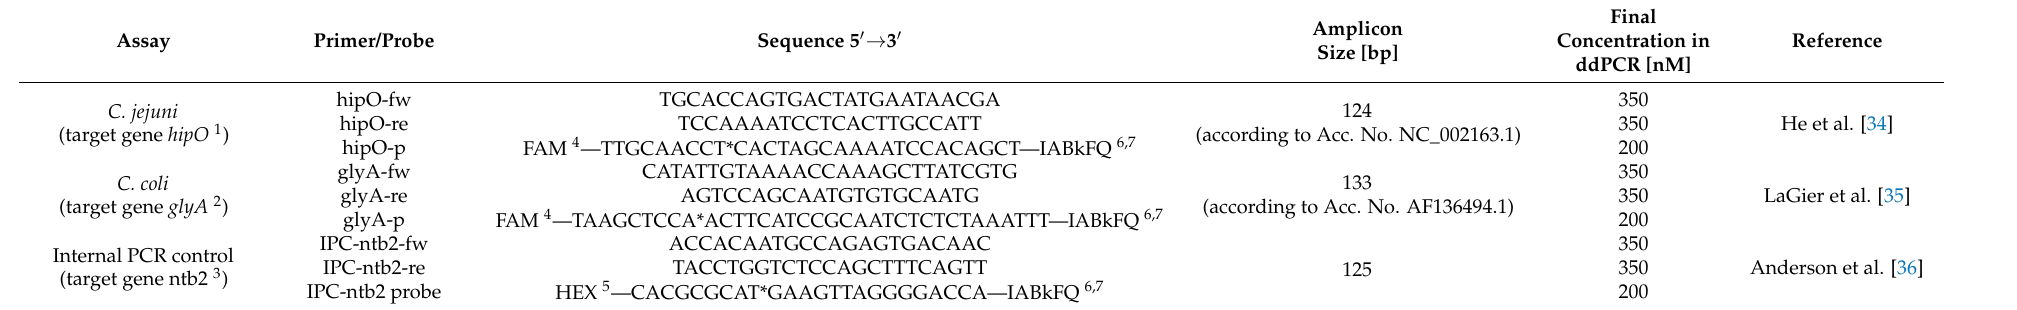
Table 1. Nucleotide sequence of oligonucleotides used in